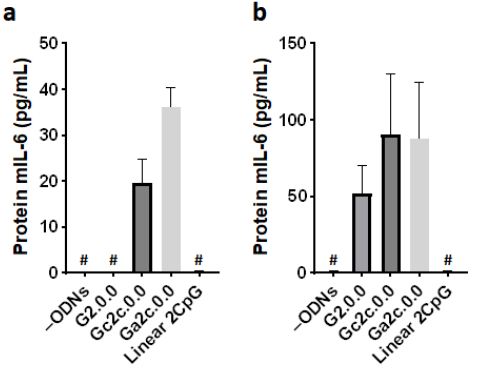
Figure 9. The level of IL ‐ 6 secreted into the culture medium induced by antiparallel type CpG